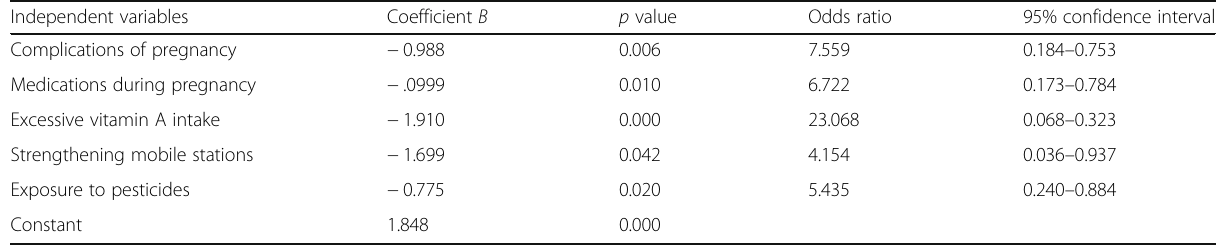
Table 5 Stepwise logistic regression analysis results for the determinants affecting the presence of CAs among infants in the Pediatric University Hospital, Alexandria, Egypt, October 2015 – May